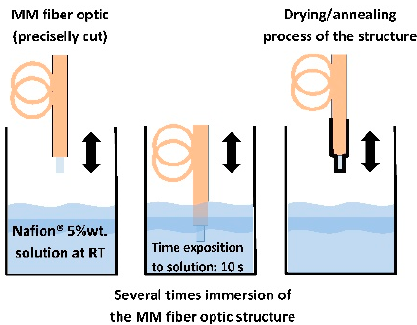
Figure 2. Technology of deposition of Nafion ® sensing thin film.